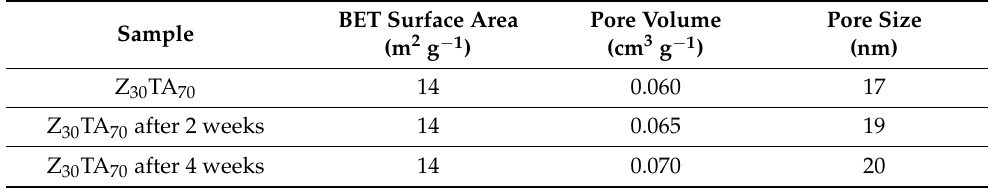
Figure 12. The stability of Z 30 TA 70 : ( a ) XRD of Z 30 TA 70 after two and four weeks ( b ) BET of Z 30 TA 70 after two and four weeks. Table 3. The physical properties of Z 30 TA 70 after stability